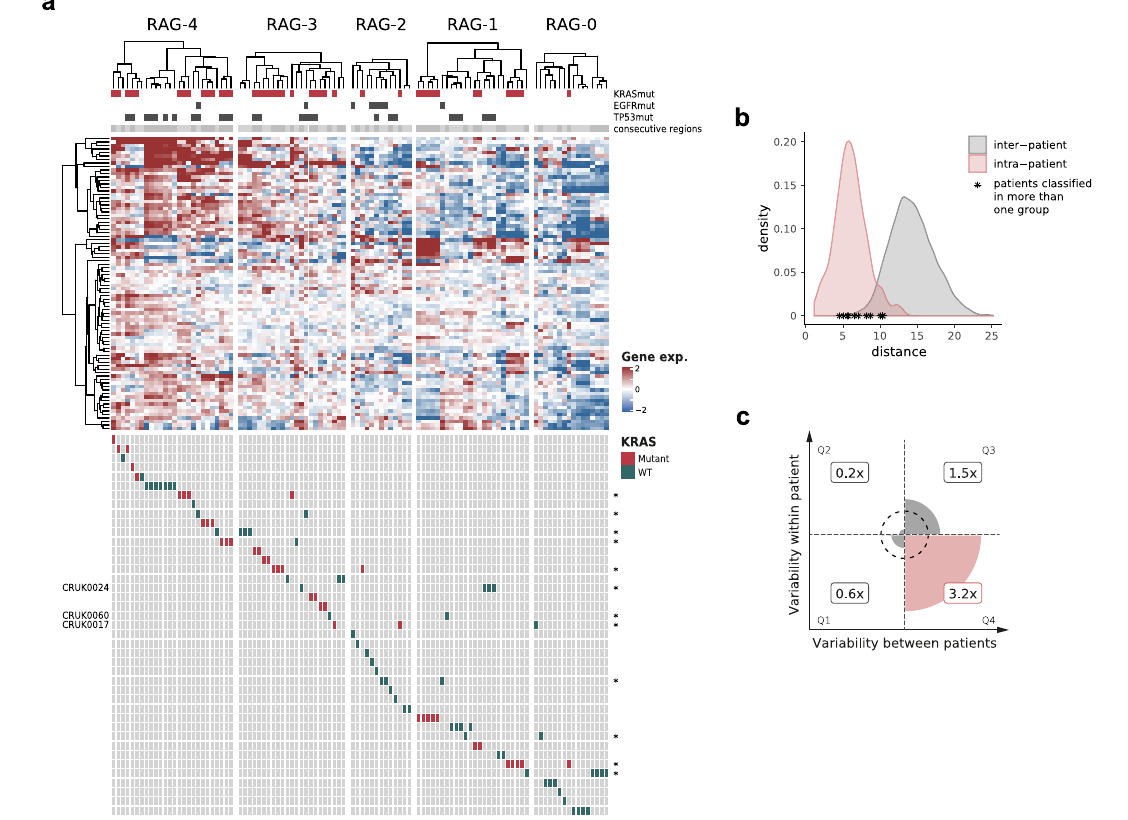
Fig. 4 | Intra-tumour RAS84 heterogeneity. a Heatmap showing RAS84 gene expression across the TRACERx multi-region cohort. The samples have been clas- si fi edintothe fi veRAGsusinganSVMclassi fi er.Contiguoussamplesfromthesame patient are indicated by the grey shades just at the top of the heatmap. Gene mutation status is indicated at the top, KRAS in red, EGFR and TP53 in grey. Per- patient regions are indicated by the rows at the bottom of the heatmap. KRAS mutants are shown in red, wild-type in green. Patients with regions spanning multiple RAGs are indicated with an asterisk. Identi fi ers are given on the left in the